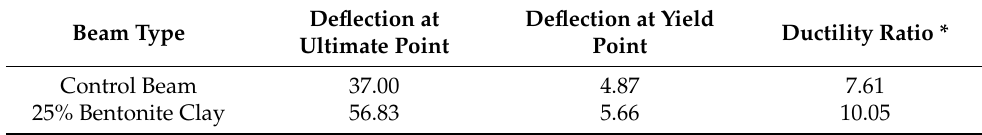
Figure 13. Load deflection curve [13]. Table 3. Ductility concrete with and without BC [13].